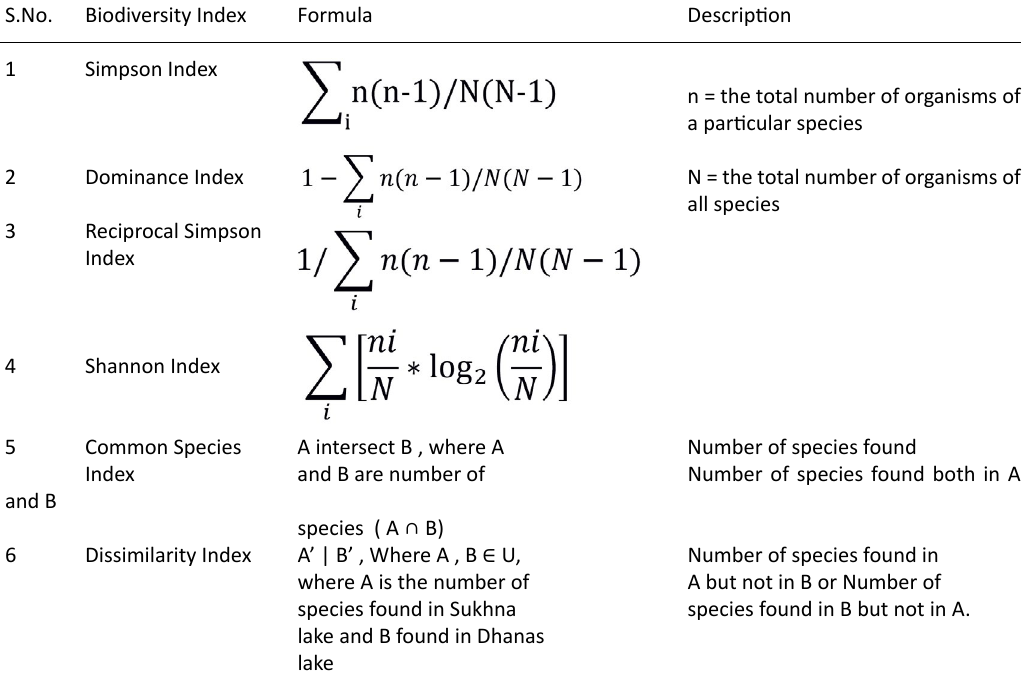
Table 1. Formulae for computing Biodiversity Indexes